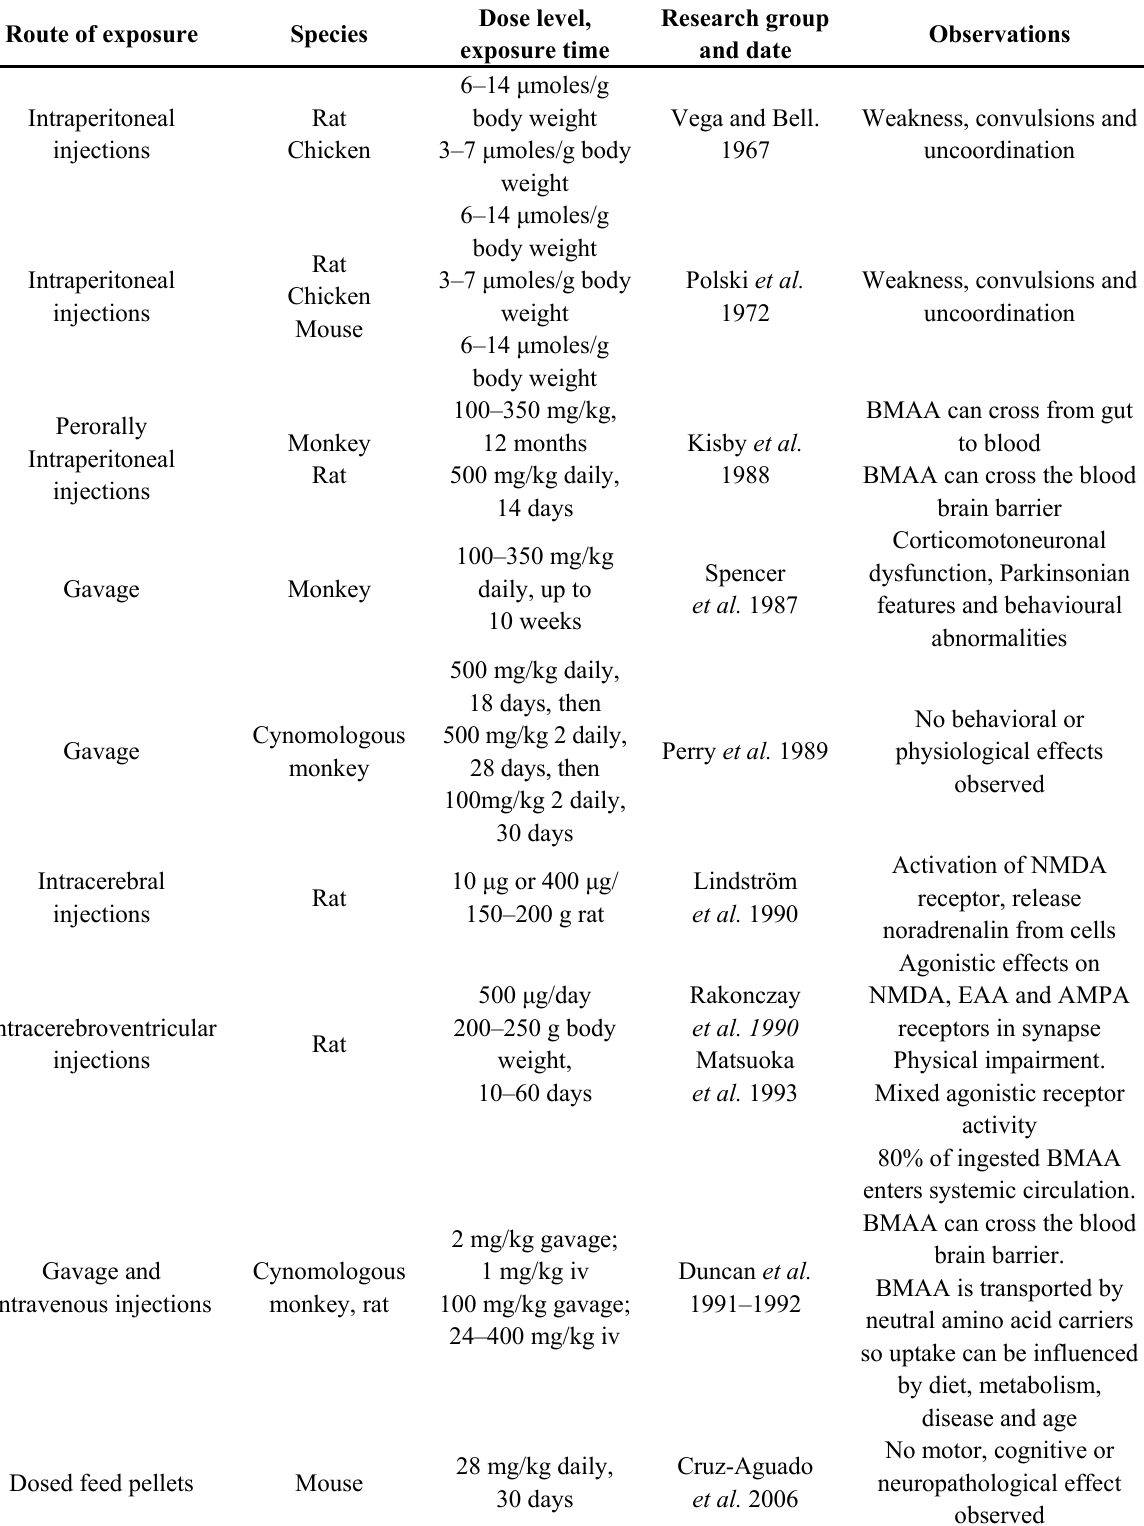
Table 1. A chronological summary of mechanisms of BMAA activity determined by in vivo